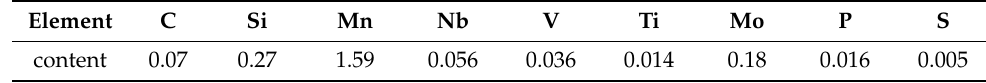
Table 1. The chemical composition of the pipeline steel